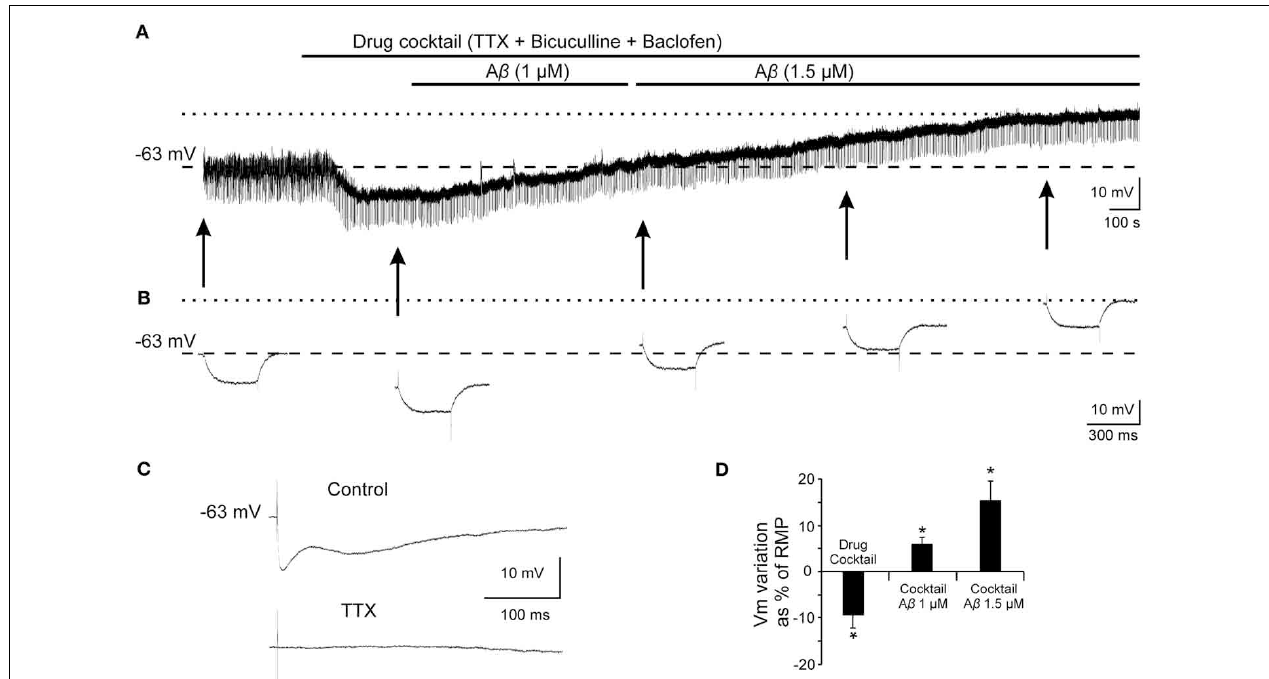
FIGURE 8 | Effects of A β 25 – 35 on postsynaptic hyperpolarization induced by activation of GABA B receptors. (A) Membrane potential recording from a CA3 neuron (top) after perfusion with TTX (1 μ M; voltage-dependent sodium channels blocker), bicuculline (10 μ M; specific blocker of GABA A receptor) and baclofen (15 μ M; agonist of GABA B receptor). This treatment ( n = 4) produced a membrane hyperpolarization depending on GABA B postsynaptic receptors activation. Perfusion with A β 25 – 35 (1 and 1.5 μ M) markedly induced the membrane to depolarize. (B) Intracellular hyperpolarizing current pulses. The arrows indicate the time points at which recordings were expanded in time to show the changes in the membrane potential during the presentation of hyperpolarizing pulses. This protocol allowed us to monitor Ri during the